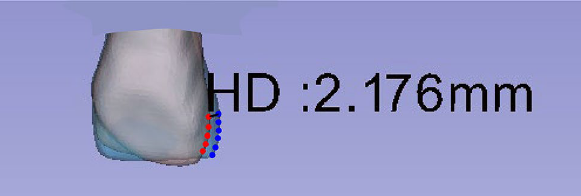
Figure 8. The Hausdorff distance between a pair of crowns. A crown shape must be as close as possible to the other crown